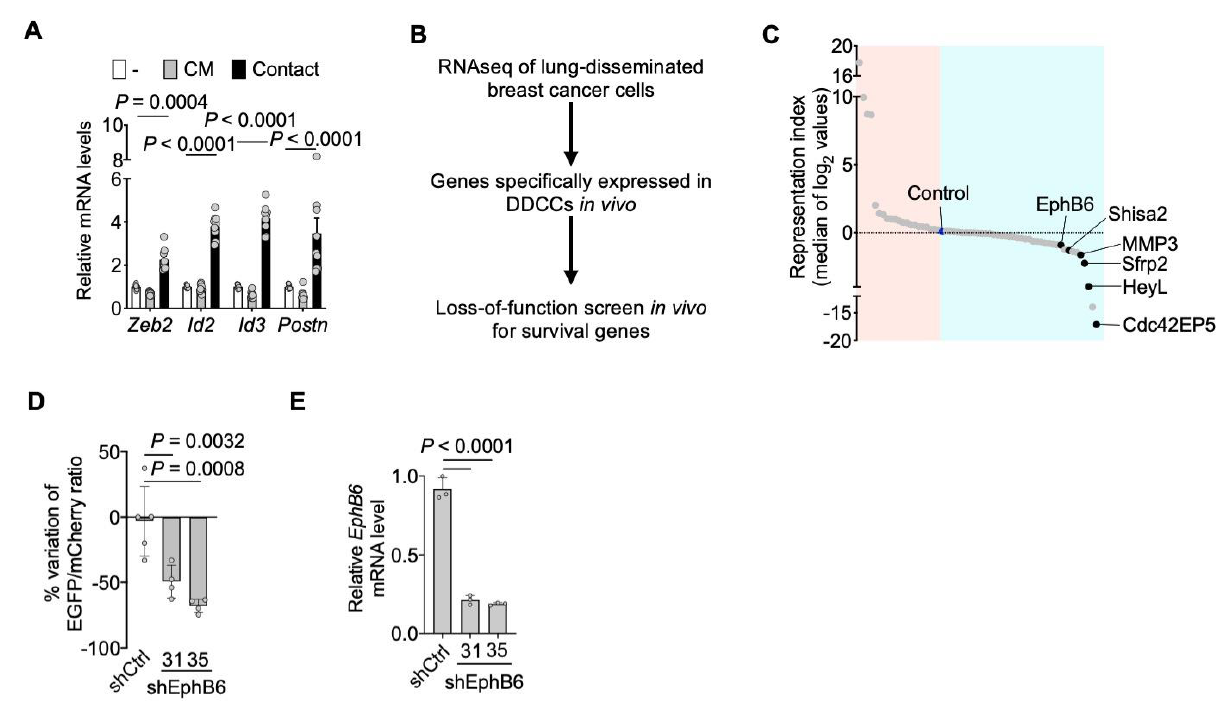
Figure 1. EphB6 supports the survival of disseminated dormant breast cancer cells. ( A ) RT-qPCR analysis of representative genes of the dormancy response. D2.0R-EGFP cells have been cultured alone, cocultured with AT1-like cells (Contact), or with conditioned medium from AT1-like cells (CM). Mean normalized pooled samples from n = 3 independent experiments. 2 way ANOVA, multiple comparisons. Error bars: SD. ( B ) Workflow of the loss-of-function screen in vivo for survival genes in disseminated dormant cancer cells (DDCCs) [8]. ( C ) Representation scores for each gene included in the screen, calculated from the fold change of representation of each shRNA relative to pre-injection abundance. On the light blue side, there are genes whose downregulation leads to a reduced representation of the clones. Black dots indicate genes (ranking among the top 10 genes) with a consistent effect of at least 2 out of 3 shRNAs included in the screening. ( D ) D2.0R-EGFP cells stably expressing the indicated shRNA were injected intravenously together with an equal amount of D2.0R-mCherry-shCtrl cells as an internal control. After 3 weeks the amount of surviving D2.0R cells was measured and the ratio EGFP/mCherry calculated. n = 5 mice for shCtrl cells, n = 4 mice for each shEphB6 sequence. One-way ANOVA test. Mean with SD. ( E ) qPCR analysis of Ephb6 mRNA in D2.0R-EGFP cells stably expressing shRNA. One-way ANOVA test. Mean with SD.